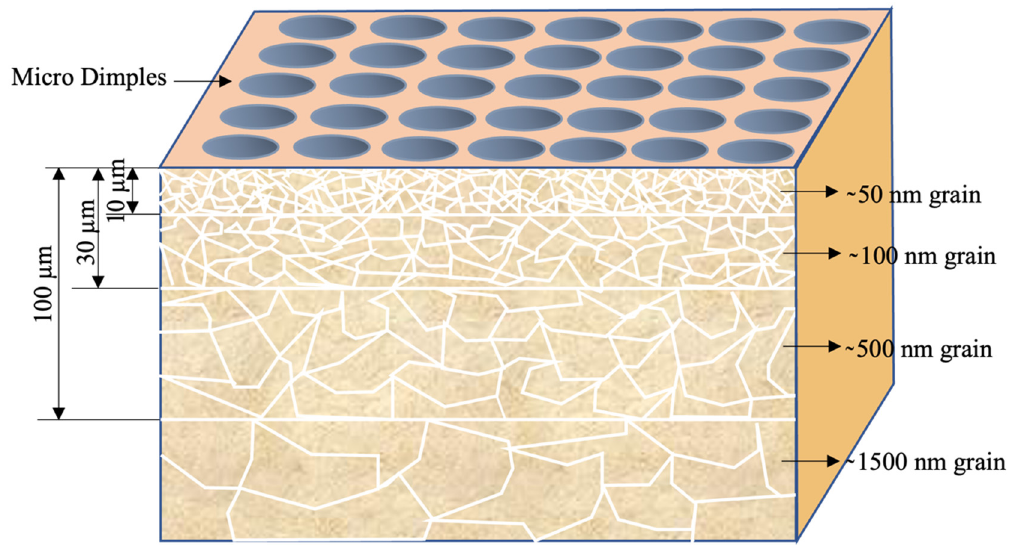
Figure 4. Schematic presentation of the grain refinement on the surface of a material subjected to UNSM. The numbers are only typical ones corresponding to a set of parameters in the selected ma- terial.